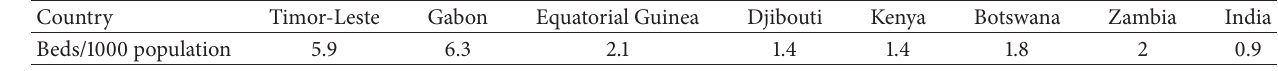
Table 4: A comparison of the availability of hospital beds for selected countries. Country Timor-Leste